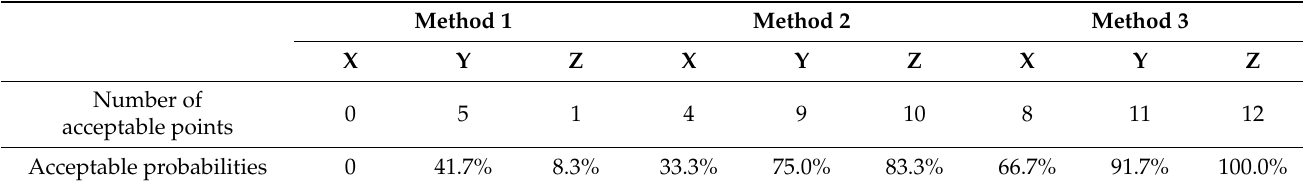
Table 6. Analysis of usable points (maximum error: 0.7